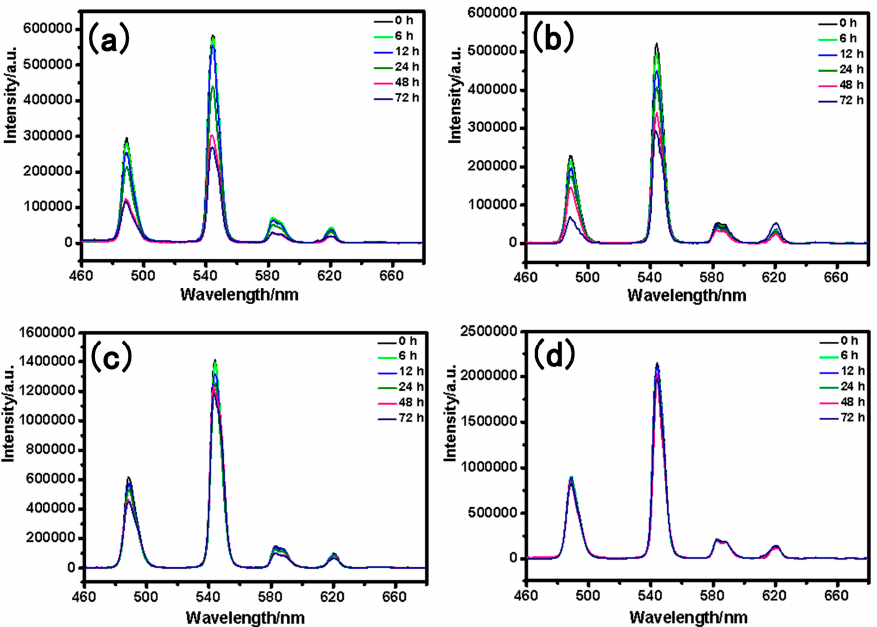
Figure 9. Fluorescent emission spectra of SiO 2 @PMDA-Si-Tb ( a ), SiO 2 @PMDA-Si-Tb-phen ( b ), SiO 2 @PMDA-Si-Tb@SiO 2 ( c ), and SiO 2 @PMDA-Si-Tb-phen@SiO 2 ( d ) after placement for 0 h, 6 h, 12 h, 24 h, 48 h, and 72 h in aqueous solution.